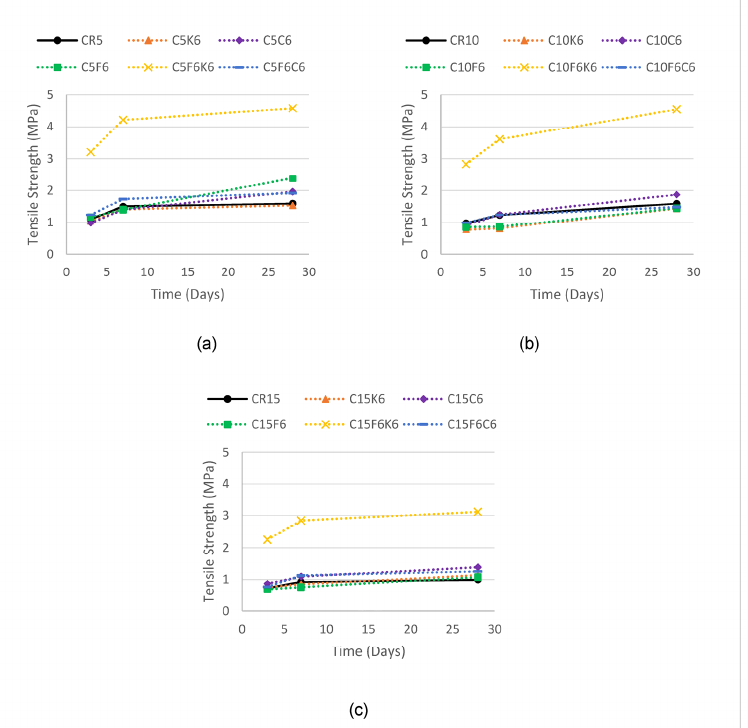
Figure 8 . Tensile strength comparison for fiber-reinforced CRM at 3, 7, and 28 days. ( a ) 5% CR replacement. ( b ) 10% CR replacement. ( c ) 15% CR replacement.